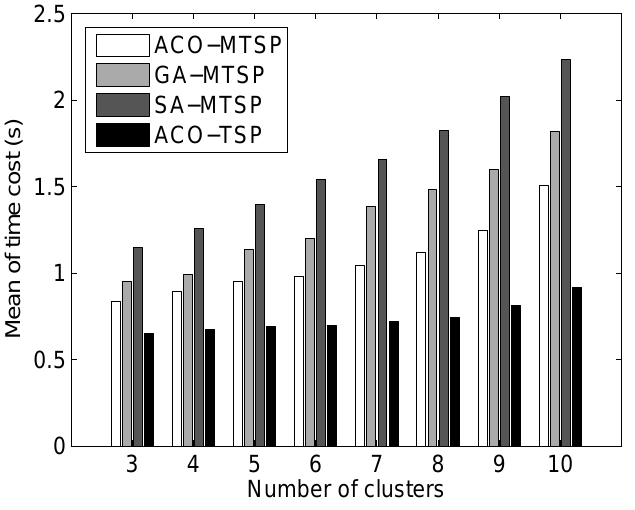
Figure 9. The mean of time cost for optimization in ACO-TSP, SA-MTSP, GA-MTSP and ACO- MTSP with different number of clusters, where the number of clusters changes from 3 to 10 and the number of sensor nodes keeps 200 for all